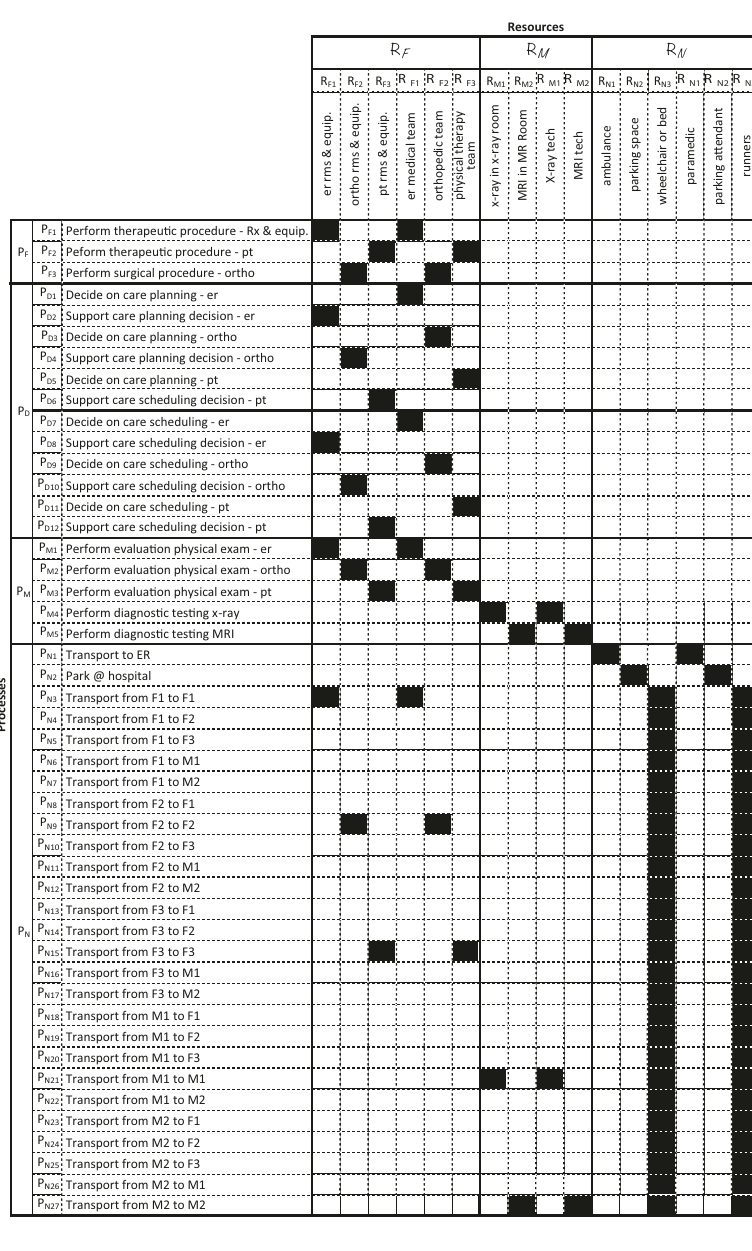
Figure5:Lowestlevelhealthcaredeliverysystemknowledgebase 𝐽 𝑆 withallocatedprocessestoresources(darkfilled)fortheacuteorthopedic